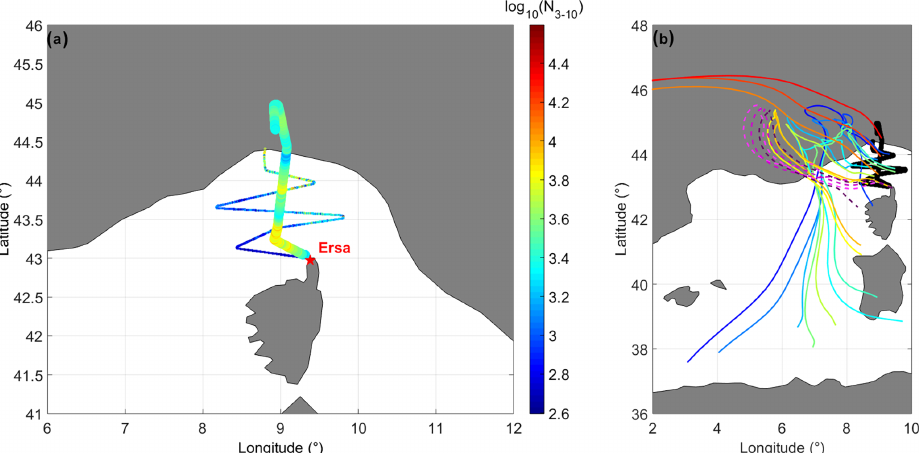
Figure 10. (a) N 3 − 10 above the threshold value along the flight path taken on 30 July. Large-size dots stand for high-altitude measurements ( ∼ 3400ma . s . l . ), while small-size dots stand for low-altitude measurements ( ∼ 215ma . s . l . ); (b) air mass back-trajectories calculated along the flight path (black line) every 10min (solid colored lines) together with the back-trajectories of air masses arriving in Ersa each hour during the same time period (dashed